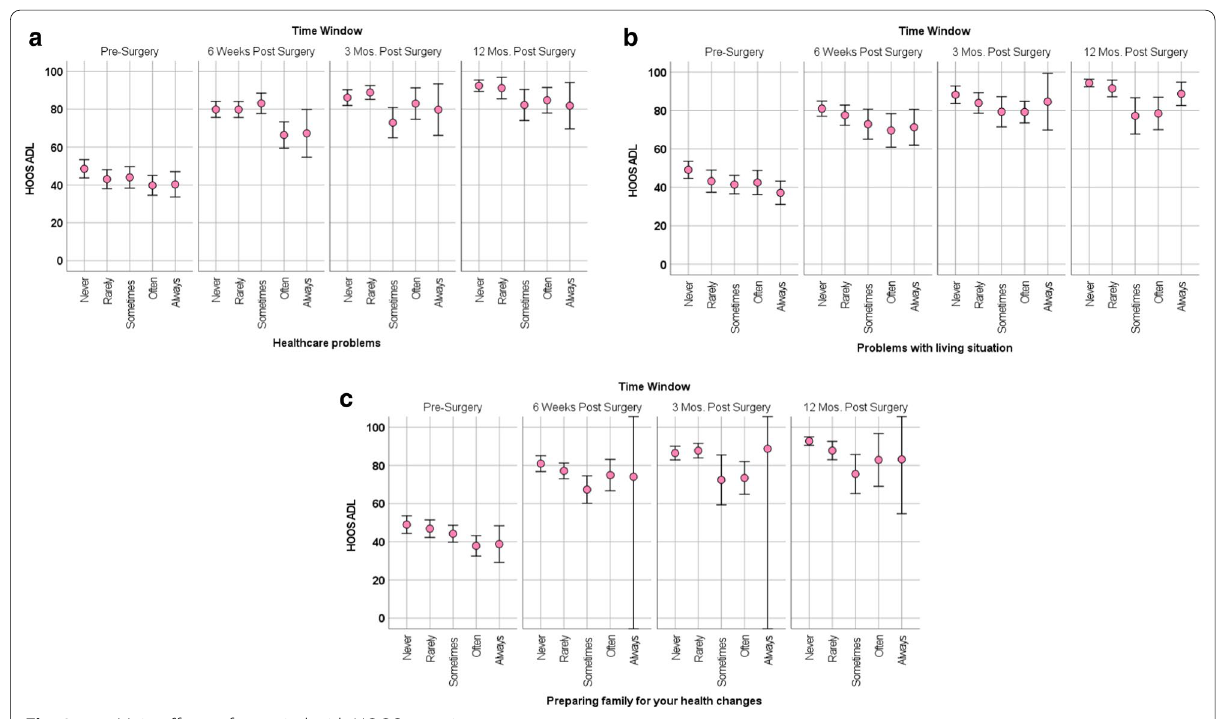
Fig. 3 a – c Main effects of appraisal with HOOS over